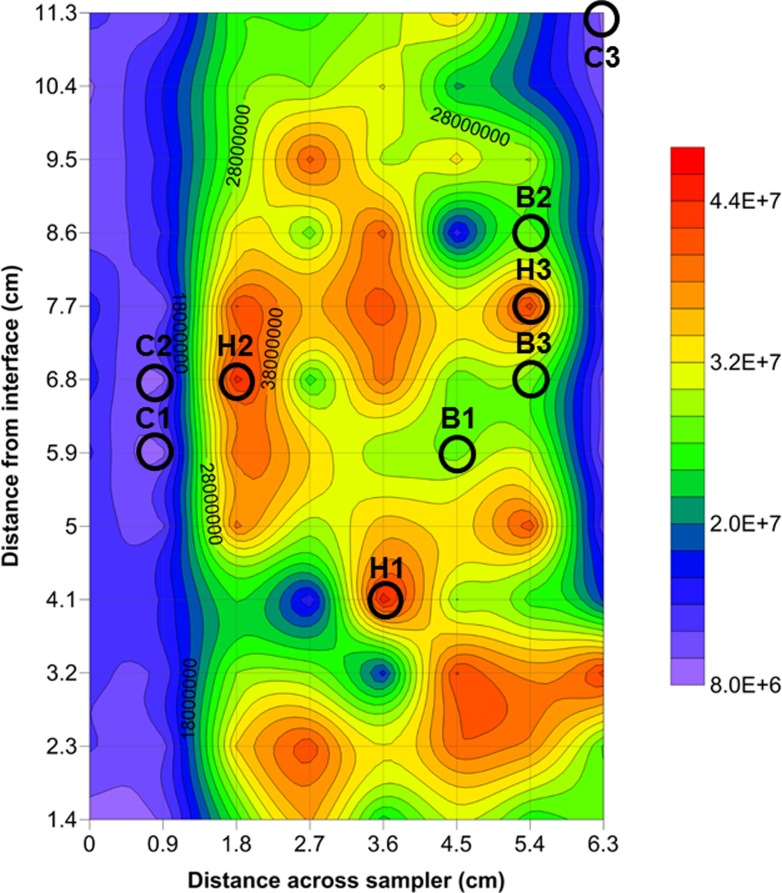
Representative two-dimensional contour plot of total prokaryotic abundance showing hotspots, coldspots and background.Circles indicate sample location and corresponding label. Faint gridlines indicate sampling intervals. Colour intensity scale in cells ml-1. Two-dimensional contour plots were created via Surfer 10 (Golden Software, Inc.). Contour plots used a conservative minimum contour interval value of ≥ 1000 events μl-1, which was higher than the maximum flow cytometric error of < 24 events μl-1.